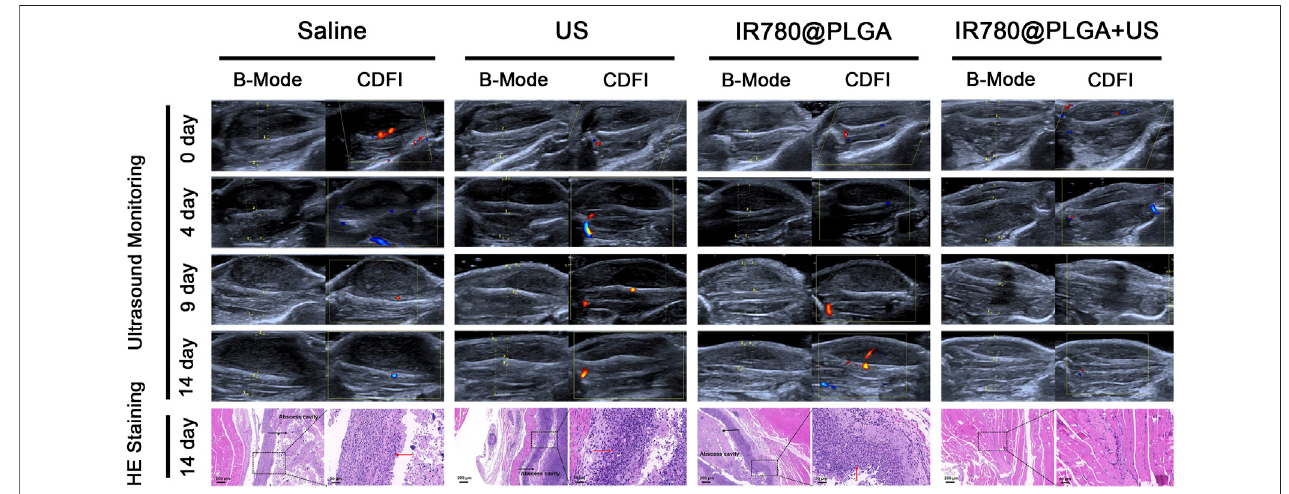
FIGURE 6 | Representative US images and histological images of the MRSA-infected mice within 14 days postinjection in different groups. The arrows in histological images indicate the in fl ammatory exudate and necrotic tissue.